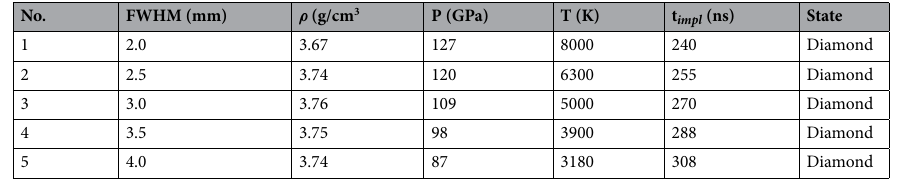
Table 1. Achieved physical conditions in compressed carbon using bunch intensity = 3 × 10 11 uranium ions, bunch length = 200 ns, particle energy = 2 GeV/u, initial sample radius, R si = 500 μm, sample mass = 17.7 mg/ cm.